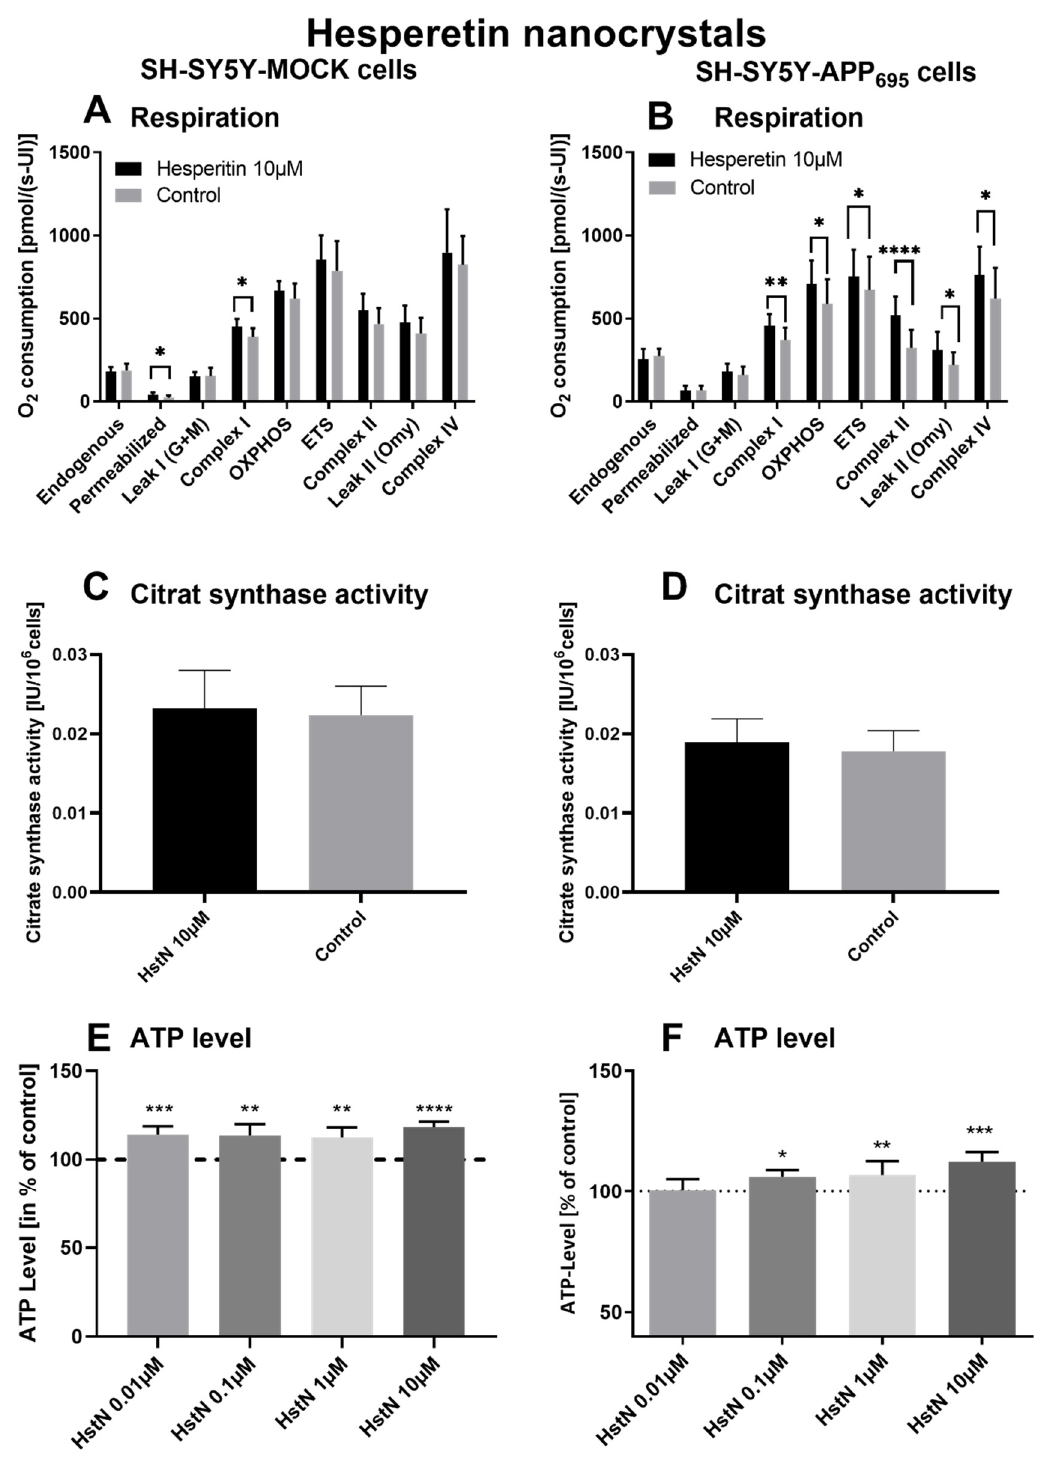
Figure 3. Respiration, citrate synthase activity, and ATP level of SH-SY5Y cells after incubation with hesperitin nanocrystals (HstN). Cells were incubated for 24 h with 10 µ M HstN or PlantaCare as control, N = 12. Respective mean values ± SD are shown. * p < 0.05, ** p < 0.01, *** p < 0.001 and **** p < 0.0001. Significance was determined by Student’s unpaired t-test. Respiration of ( A ) SH-SY5Y-MOCK and ( B ) SH-SY5Y-APP 695 cells adjusted to international units (IU) of citrate synthase activity. Citrate synthase activity of ( C ) SH-SY5Y-MOCK cells and ( D ) SH-SY5Y-APP 695 cells. Values are given as IU of citrate synthase activity. ATP level of ( E ) SH-SY5Y-MOCK cells and ( F ) SH-SY5Y-APP 695 cells after 24 h incubation with 0.01–10 µ M HstN. Cells treated with cell culture medium served as control (100%).